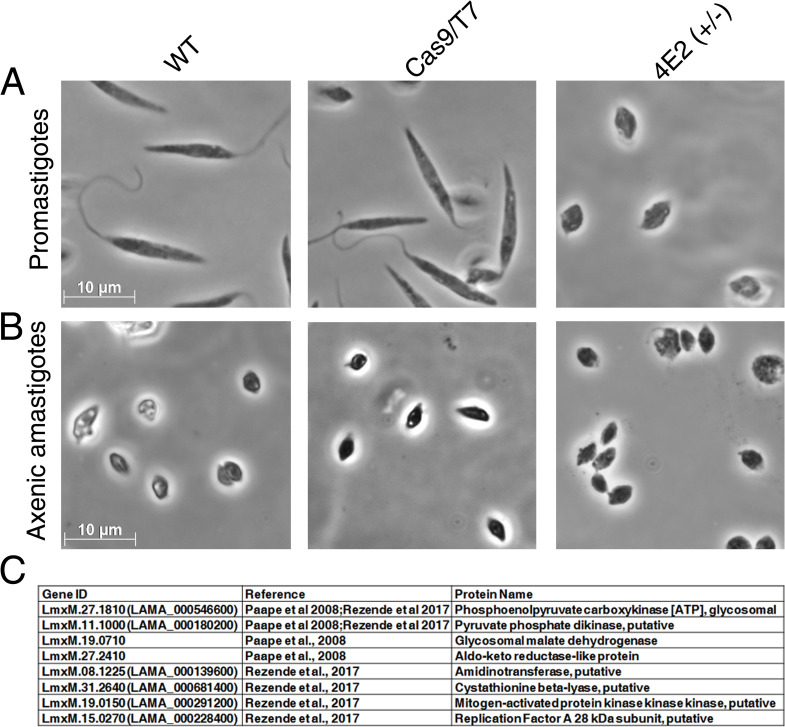
LeishIF4E2(+/-) mutant cells easily transform to axenic amastigote-like cells.(A) Promastigotes of the LeishIF4E2(+/-) mutant, control WT, and Cas9/T7 expressing cells grown under normal conditions are shown. (B) Morphology of cells transferred to conditions that induce differentiation to axenic-amastigotes (33°C/pH 5.5) during four days. Images were captured at 100x magnification with a Zeiss Axiovert 200M microscope equipped with AxioCam HRm CCD camera. The scale bar is 10 μm. (C) Shared upregulated proteins in the mutant LeishIF4E2(+/-) promastigotes (compared to Cas9/T7 cells) and in published amastigotes proteome. The total protein of the LeishIF4E2(+/-) mutant promastigotes was compared to the proteome of Cas9/T7 cells. The list of upregulated proteins was further compared with the proteins enriched in the amastigote proteome of the virulent L. amazonensis PH8 strain (de Rezende et al, PLOS NTD 2017) and of L. mexicana amastigotes (Paape et al, Mol Cell Prot 2008). L amazonensis gene IDs were converted to L. mexicana, for the sake of comparison.